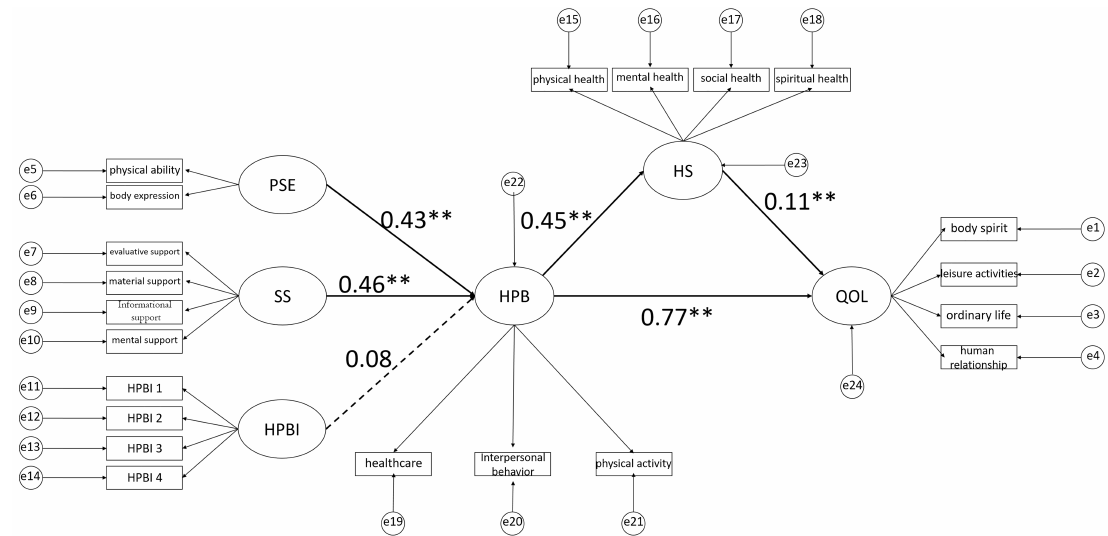
Fig. 2. Conceptual framework. Note: QoL, quality of life; SS, social support; PSE, physical self-efficacy; HPBI, health promotion behavioural intention; HS, health status; HPB, health promotion behaviour. This framework and further computation are performed in the AMOS